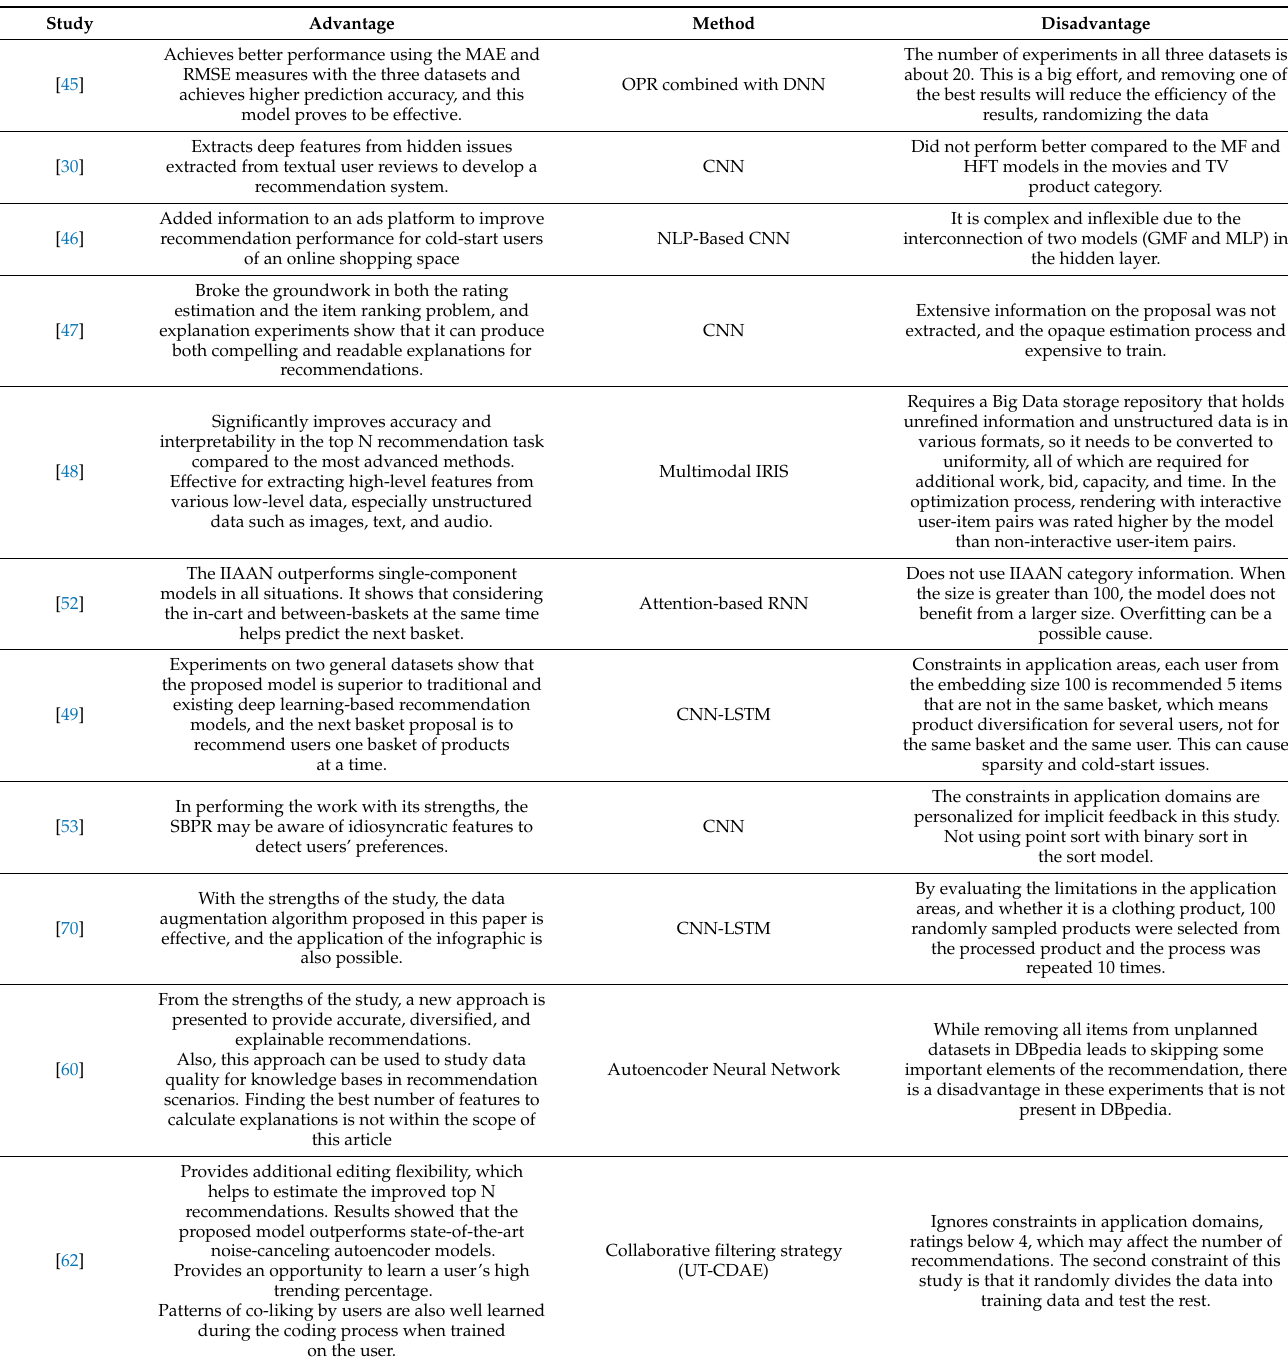
Table 1. Finding